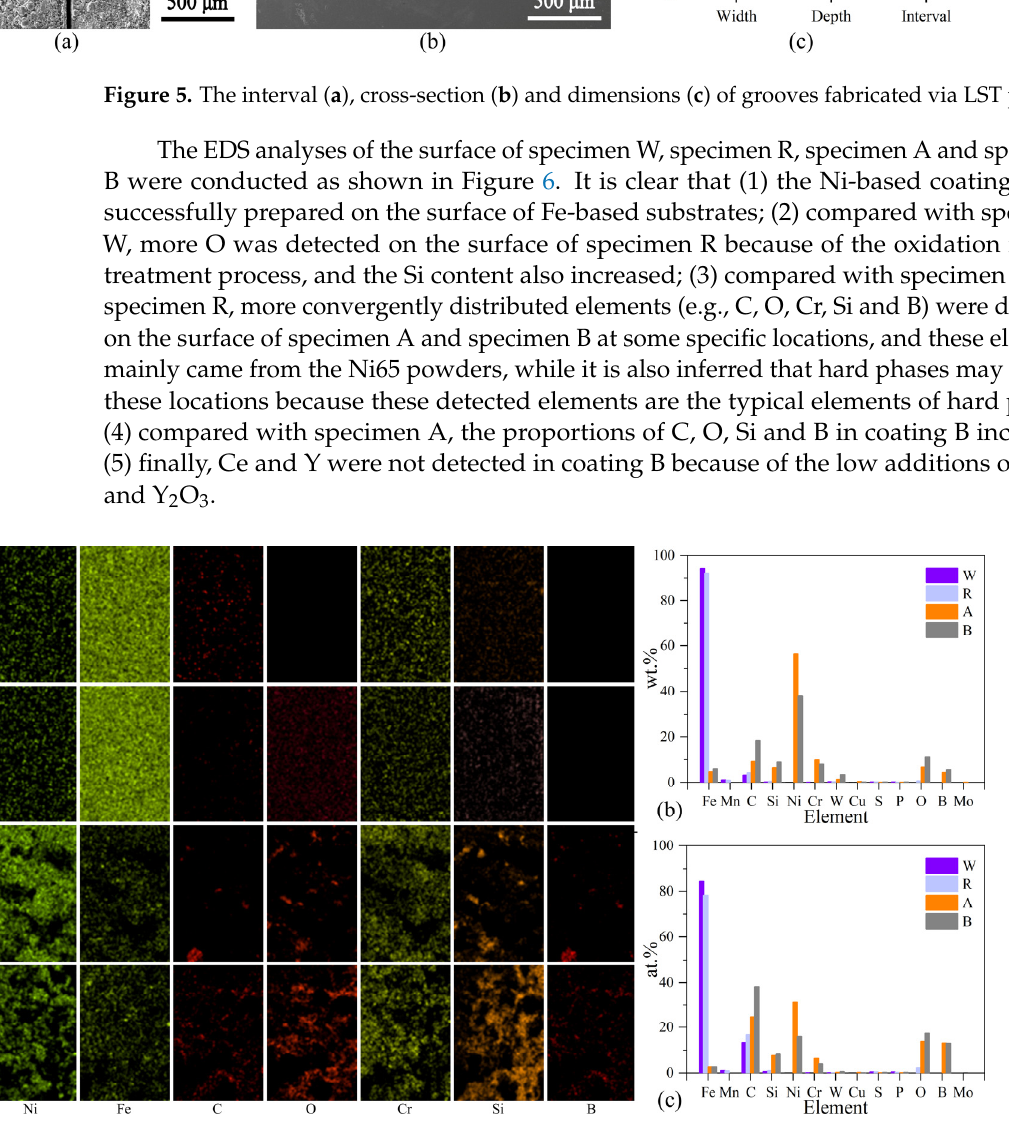
Figure 6. EDS analysis results of the surface of specimen W, specimen R, specimen A and specimen B. Distribution maps ( a ), weight percentage ( b ) and atom percentage ( c ) of the chemical elements.